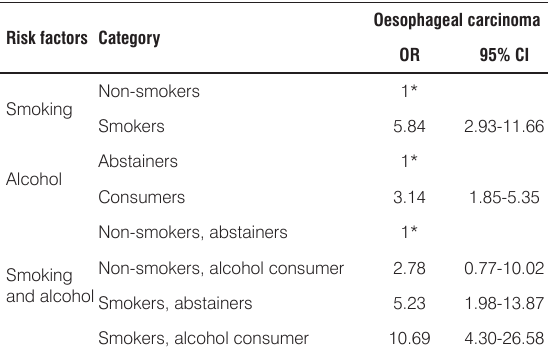
Table 3. Effects of tobacco smoking and alcohol consumption on the risk of oesophageal cancer by crude odds ratio (multivariable